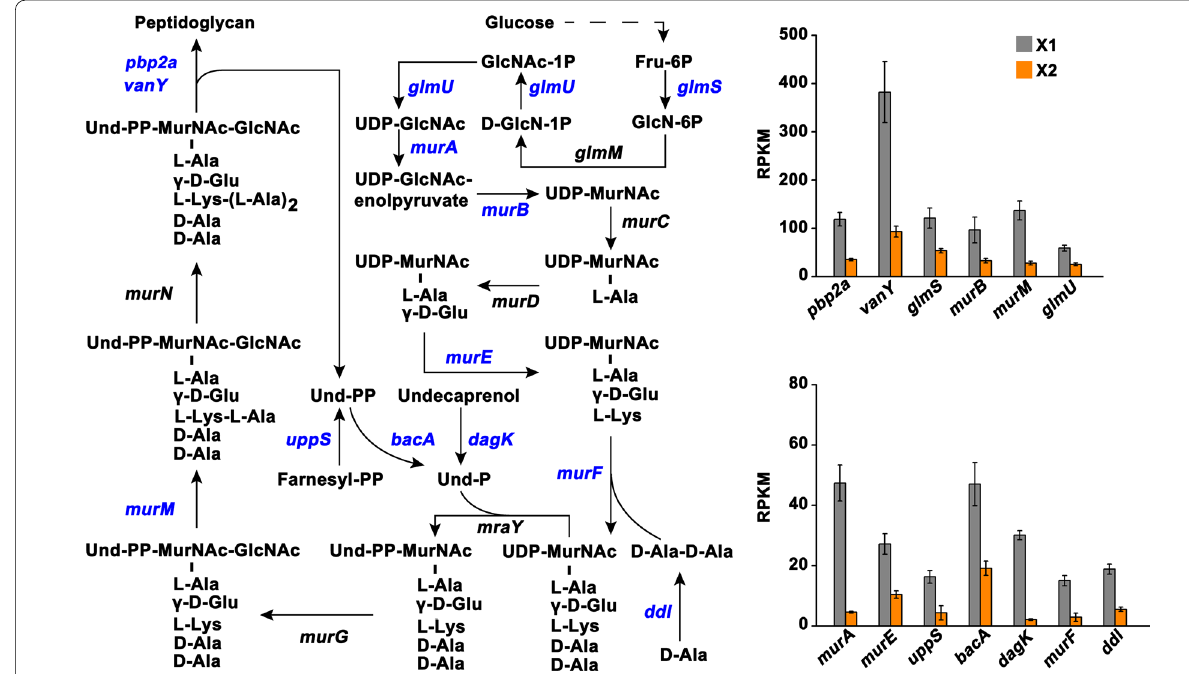
Fig. 6 Changes in the expression of genes involved in peptidoglycan biosynthesis. Genes colored with blue indicate downregulation. Expression level shown as RPKM was displayed by mean standard deviation. Dashed arrow indicates multiple steps. The detailed information of these DEGs ± were presented in Additional file 1: Table S1